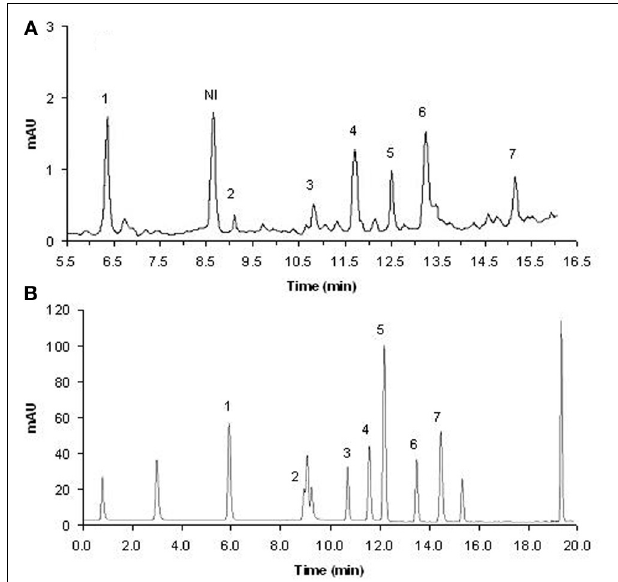
FIGURE 2 | Time-courses of dry matter accumulation patterns of total aerial biomass ( • ) and plant fractions ( ◦ , leaf; (cid:2) , stem; (cid:2) , ear; (cid:3) , root). Data are means of three replicates, vertical lines represent ± standard error. † T, tillering; SE, stem elongation; B, booting; H, heading; F, flowering; MD, milk development; DD, dough development; KH, kernel